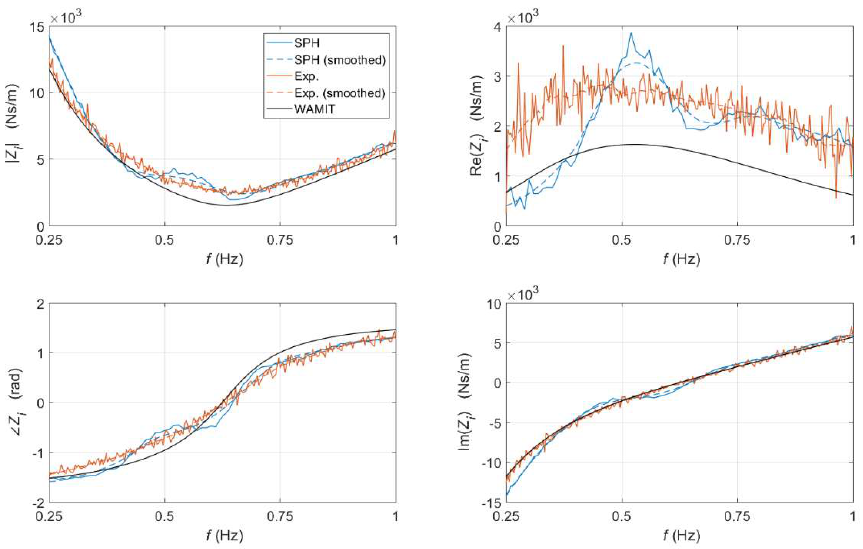
Figure 8. Intrinsic impedance calculated from the physical tests, using WAMIT and using Du- alSPHysics.